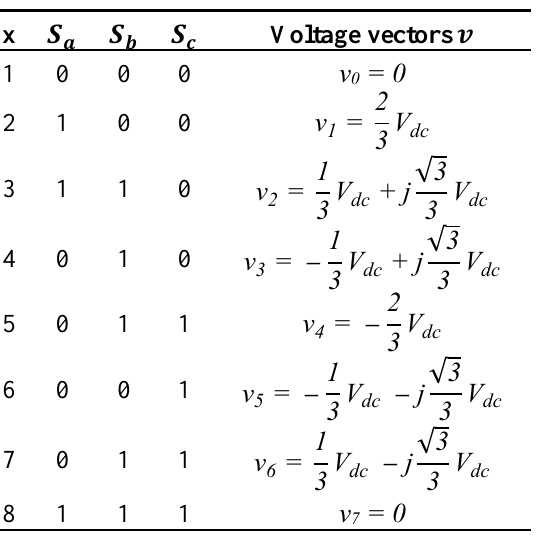
Table 1. Switching states and voltage vectors